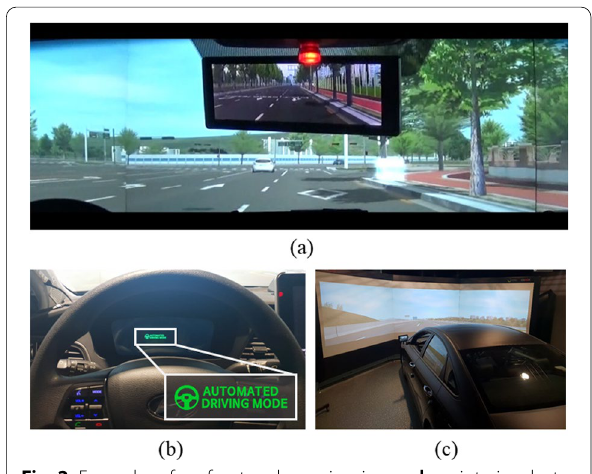
Fig. 2 Examples of a a front and rear view image, b an interior cluster view, and c an exterior view of the virtual driving simulator